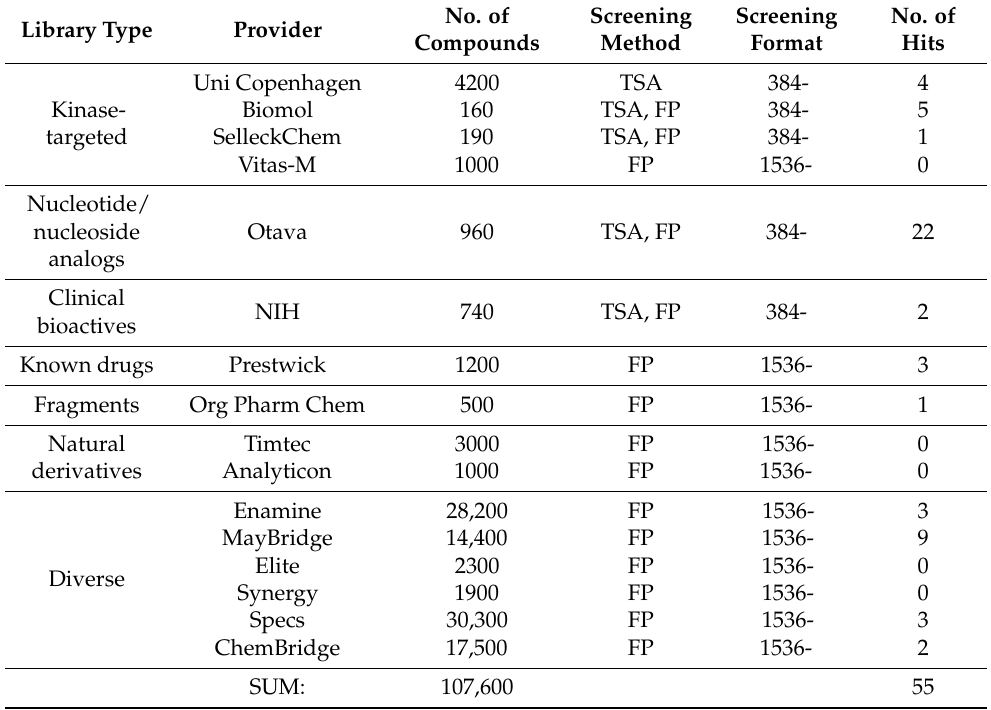
Table 1. Summary of libraries screened and number of hits. A total number of 107,600 small molecules were screened against recombinant JAK2 JH2 V617F by thermal shift assay (TSA) and/or fluorescence